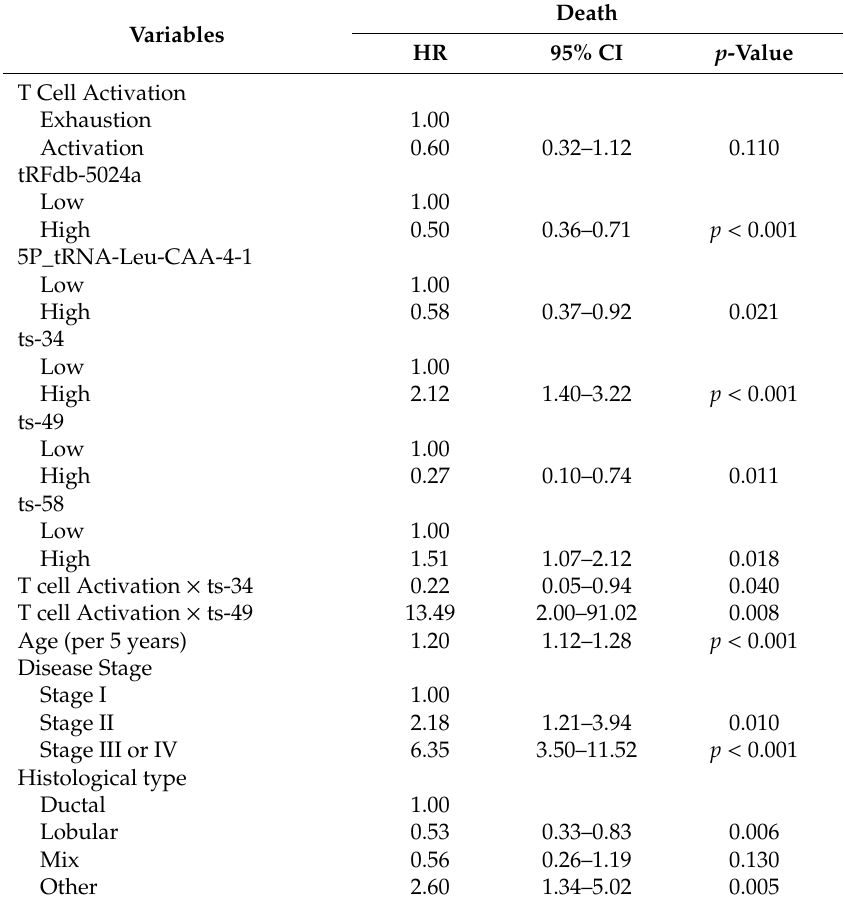
Table 2. Interactions between T cell activation status and tRFs in the whole sample.